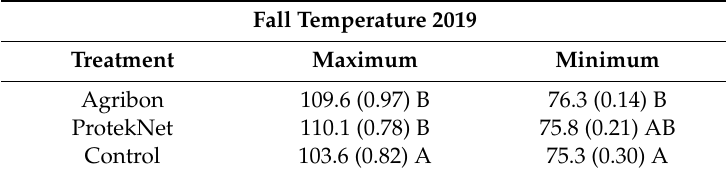
Table 4. E ff ect of treatment on temperature (Fahrenheit) in the fall trial.